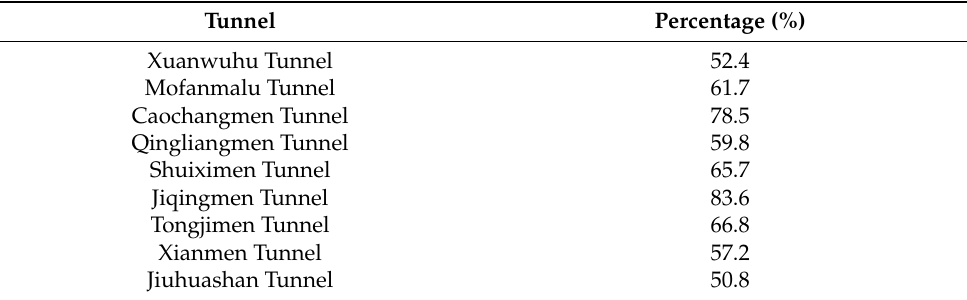
Table 5. Percentage of driver gaze in the safe